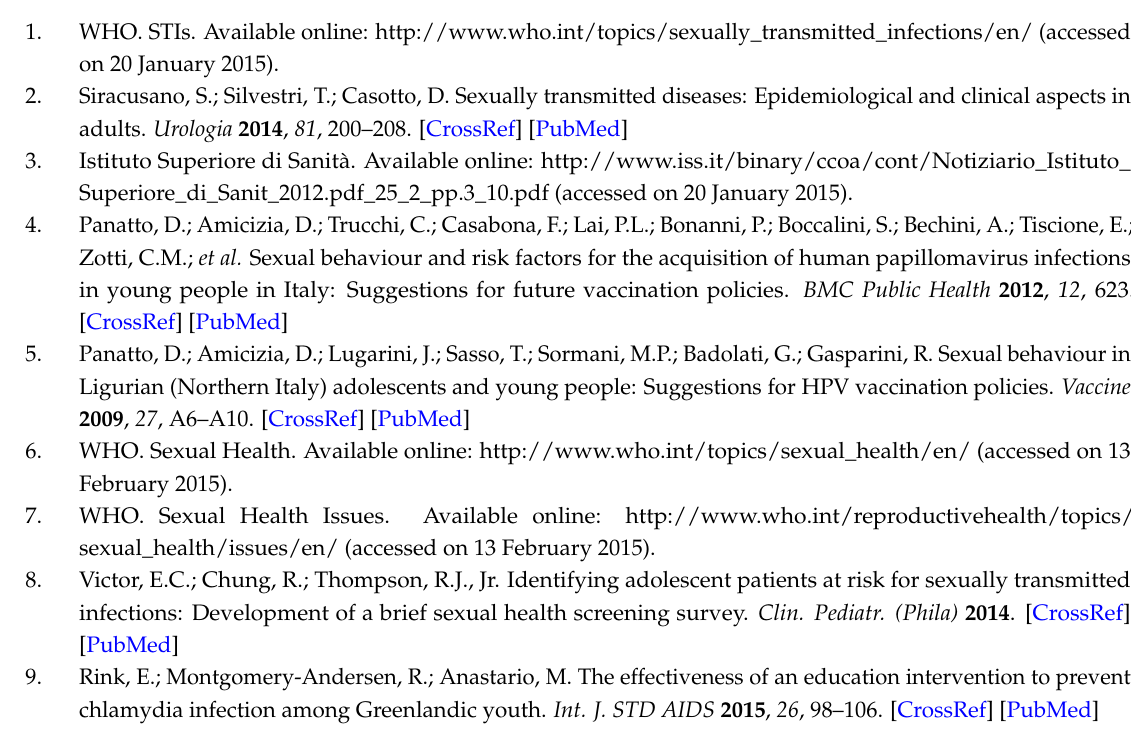
Figure S1: Details about sources of sexual